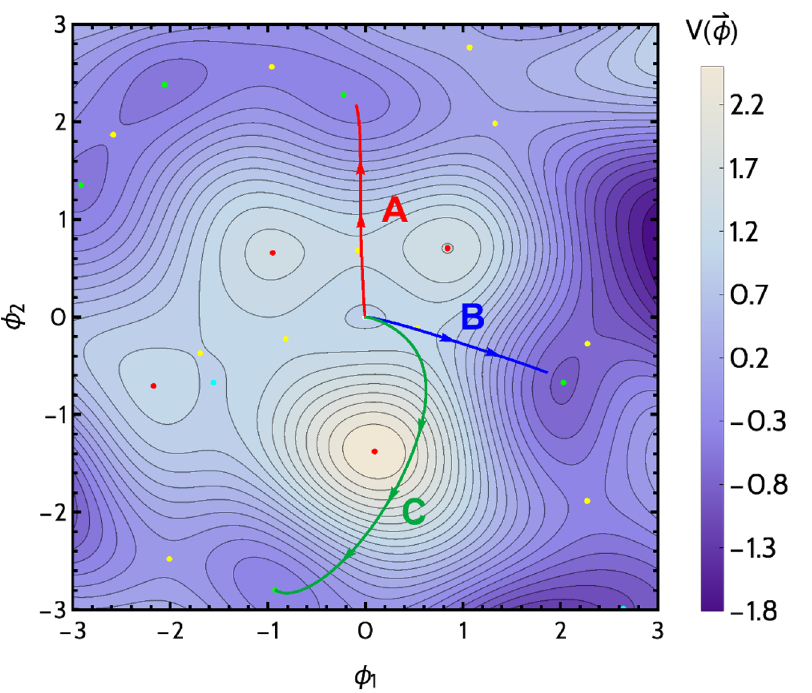
Figure 3. A typical example of the considered tunneling events. After generating a GRF with a minimum at the center with height 1 (in terms of U 0 ), we compute possible tunnelings with AnyBubble. The plot shows the GRF along with its minima (green), saddles (yellow), maxima (red) and in(cid:13)ection points (blue) as well as 3 of the instanton trajectories in (cid:12)eld space for 3 decay channels.